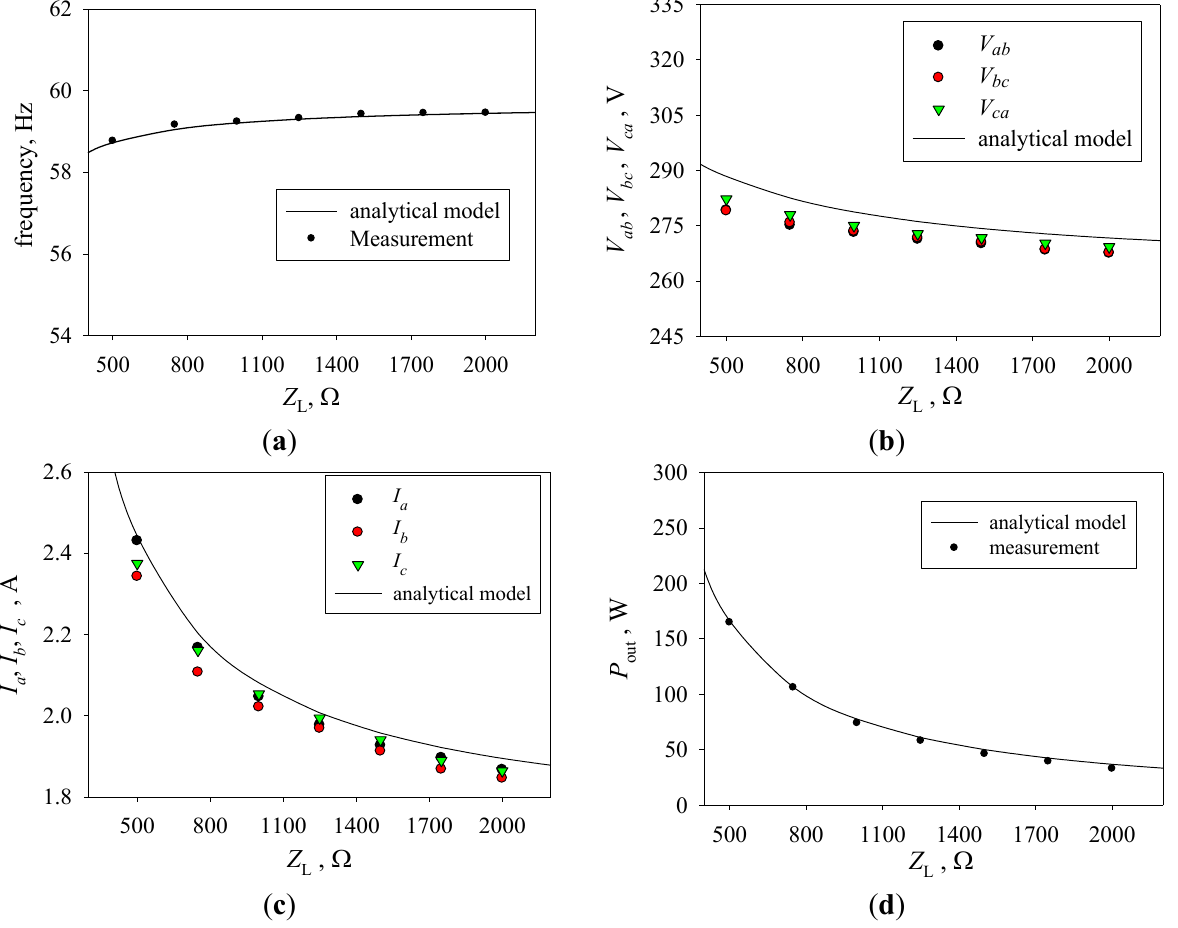
varying from 500 Ω to 2000 Ω. L